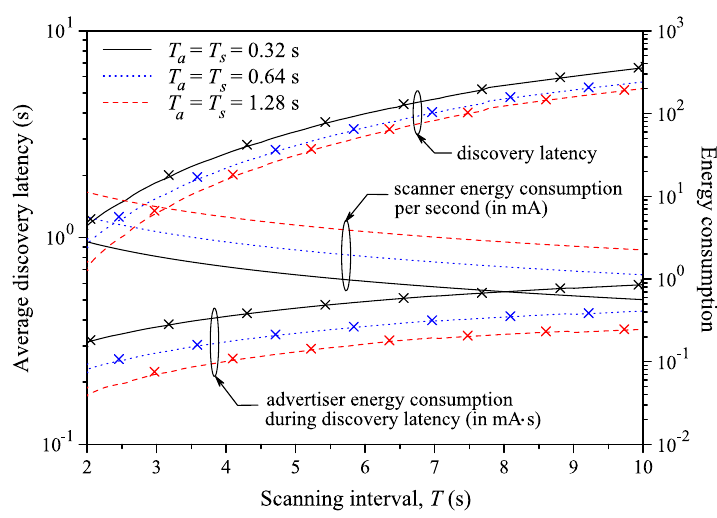
Figure 22. Average discovery latency and energy consumption of the advertiser according to T a Fig. 7. Tradeoff between average discovery latency and energy consumption of the scanner according to T and T s , in the proposed model ( M = 10, and ( T s = 1.28 s and T = 10.24 s) [78]. The green line shows the model proposed by [76], while the black p o = 0.1). and blue lines positioned in the lower part show the models analyzed in [78]. The crosses represent the simulation based on the theoretical model. As can be noticed, when T a > T s , the two results do not agree. On the other side, the red line [79] and the two blue and black lines positioned in the upper part of the figure represent the data relative to the latency, analyzed in Section 3.4. Adapted from [78].